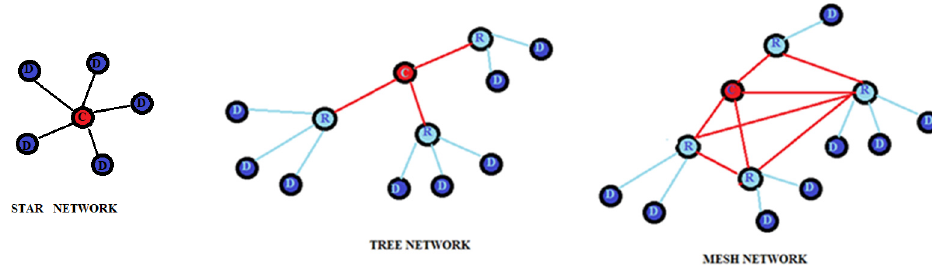
Figure 13. Network topologies.